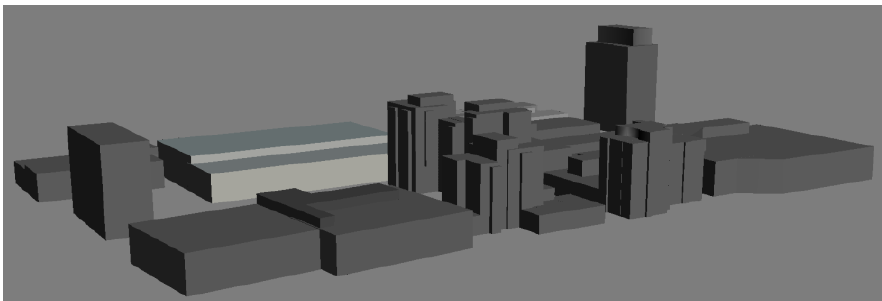
Figure 13. Raw models of Tapiola area produced using 3ds